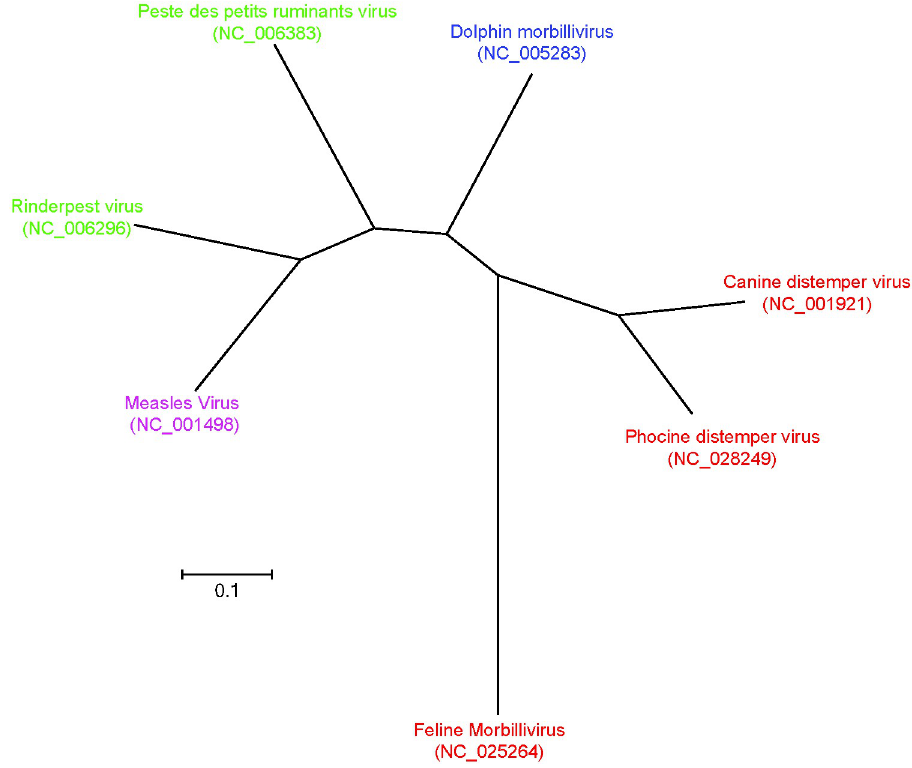
Fig 1. Phylogenetic tree based on full length referencesequences of membersof the morbillivirus group. GenBank accession numbers are includedin brackets, and primary host groups indicatedby ruminants (green), cetacean(Blue), human (Pink), and carnivores (Red).